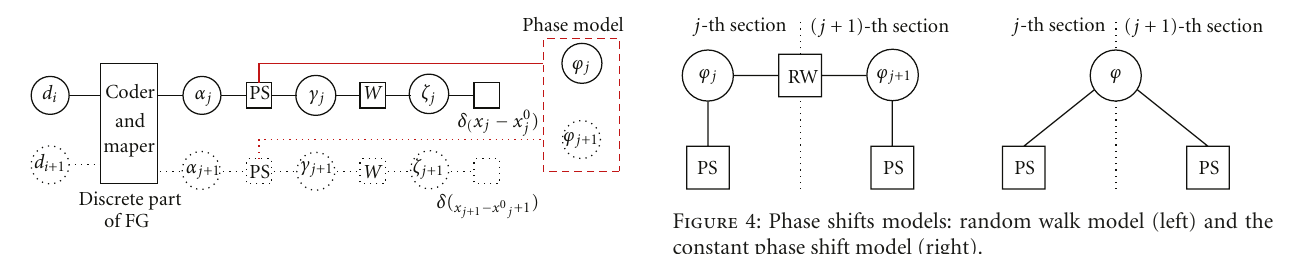
Figure 3: Factor graphs of the models.